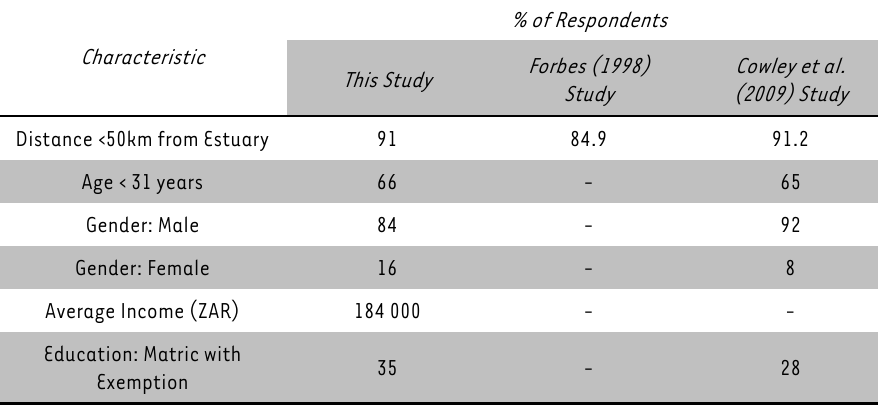
% of Respondents Forbes (1998) Cowley et al. This Study Study (2009) Study